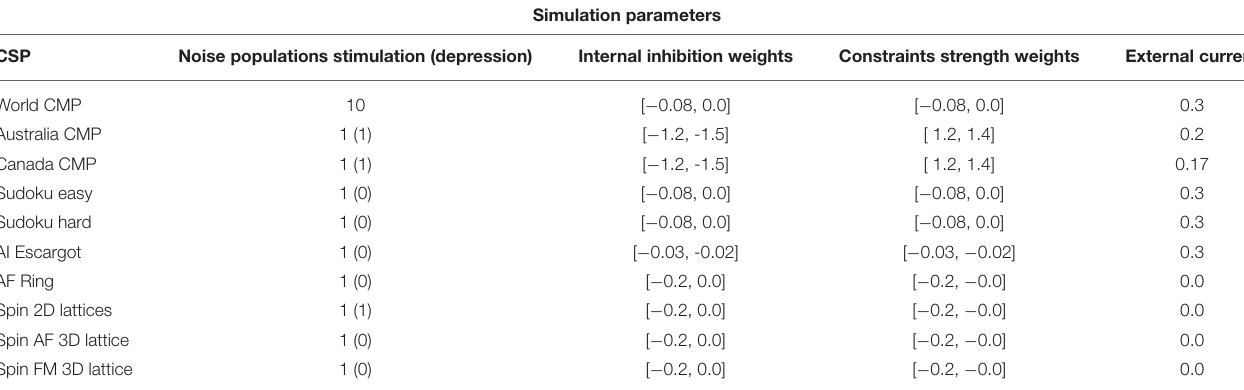
TABLE 2 | Simulation parameters for the SNN solvers of the CMP, Sudoku, and Spin Systems.